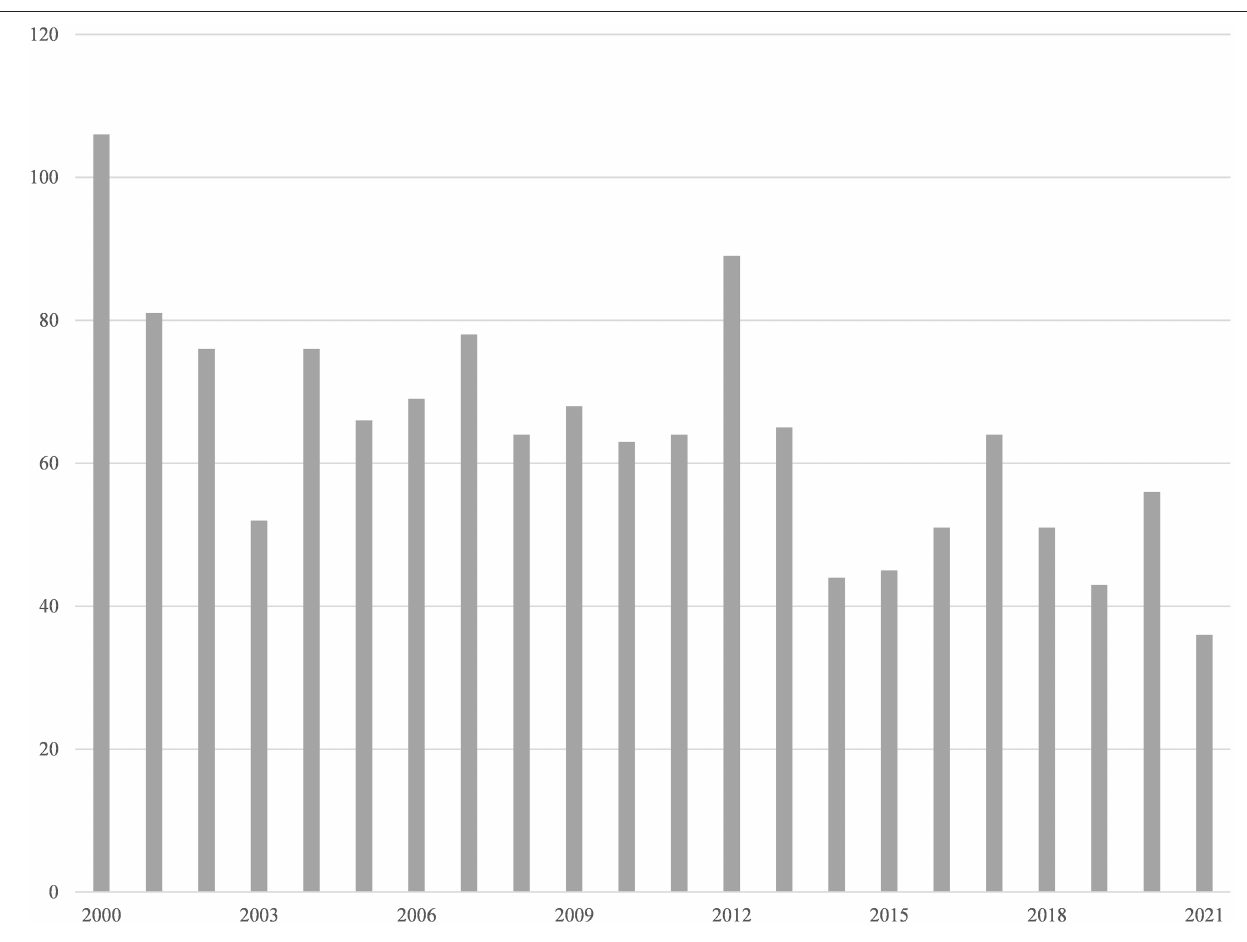
FIGURE 1 | PubMed search results: articles per